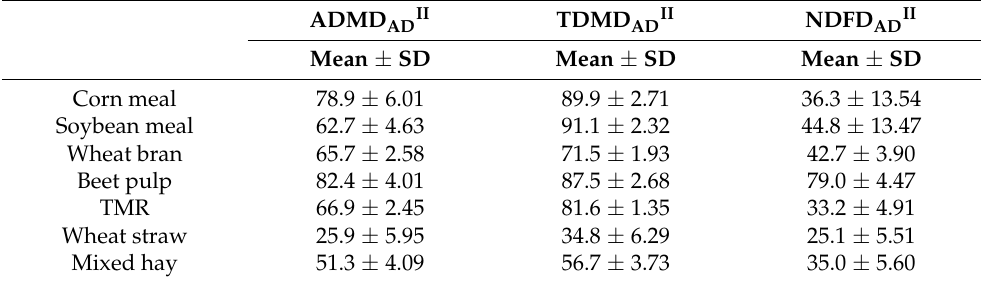
Table 2. In vitro digestibility of feeds used to assess the effect of RF storage time (N =